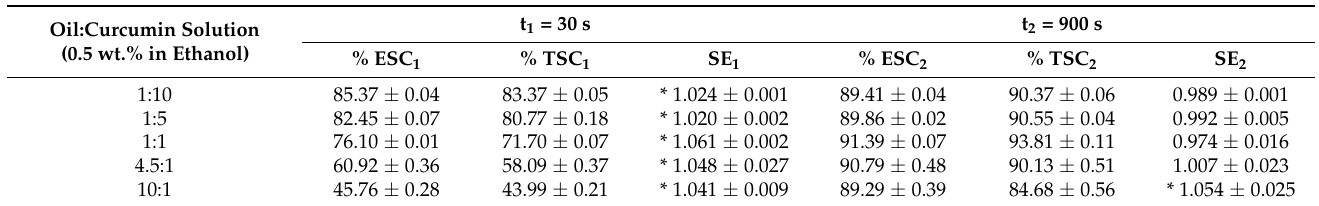
Table 3. Synergistic effect (SE) and experimental scavenging capacity (% ESC) of antioxidant mixtures at 30 s and 900 s.